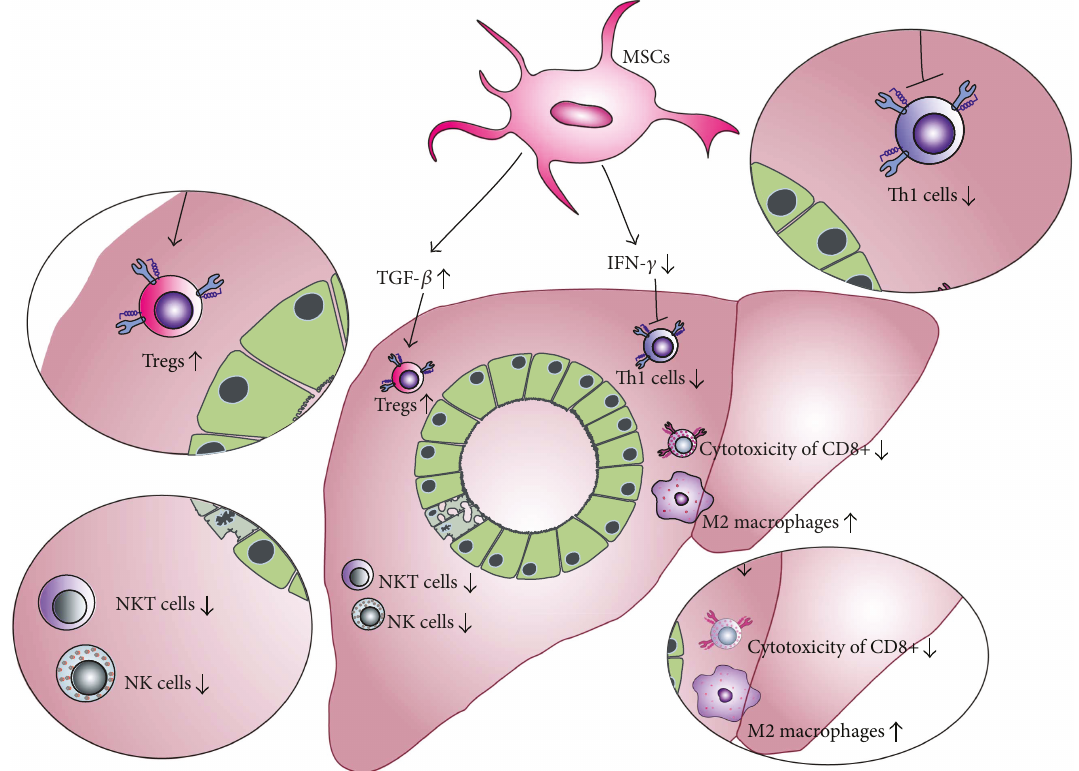
Figure 2: MSC-based attenuation of immune response in PBC. MSCs modulate immune response and attenuate PBC by producing TGF- β that resulted in an increased expansion of Tregs and anti-in fl ammatory M2 macrophages. Additionally, MSCs attenuate production of in fl ammatory cytokines, particularly IFN- γ , and suppress Th1 immune response including inhibition of IFN- γ -producing CD4+Th1 cells, cytotoxic CD8+ T lymphocytes, NK, and NKT